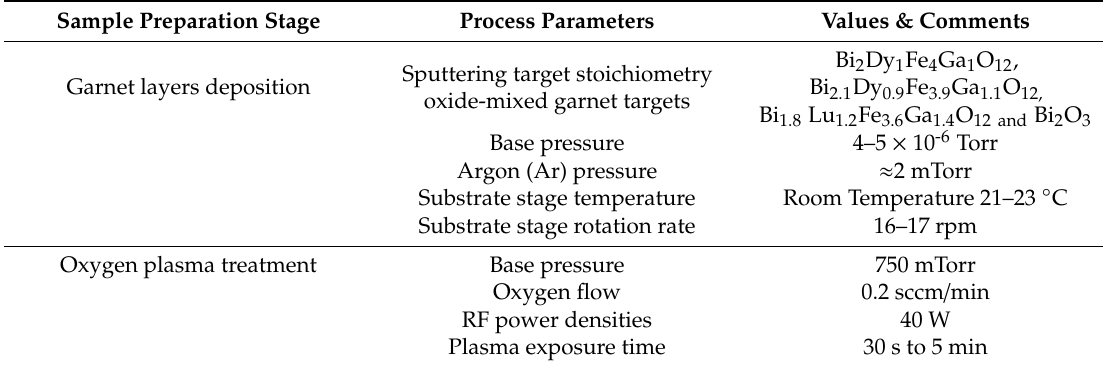
Table 1. Summary of process parameters used to prepare the garnet